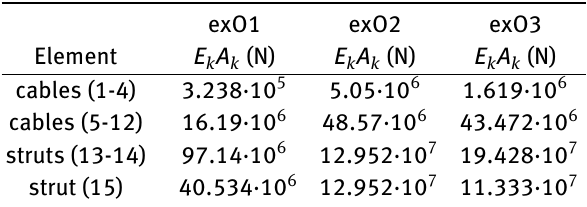
Table 8: Axial stiffness of the elements of the Octahedral cell which also lead to the results obtained in the literature exO1 exO2